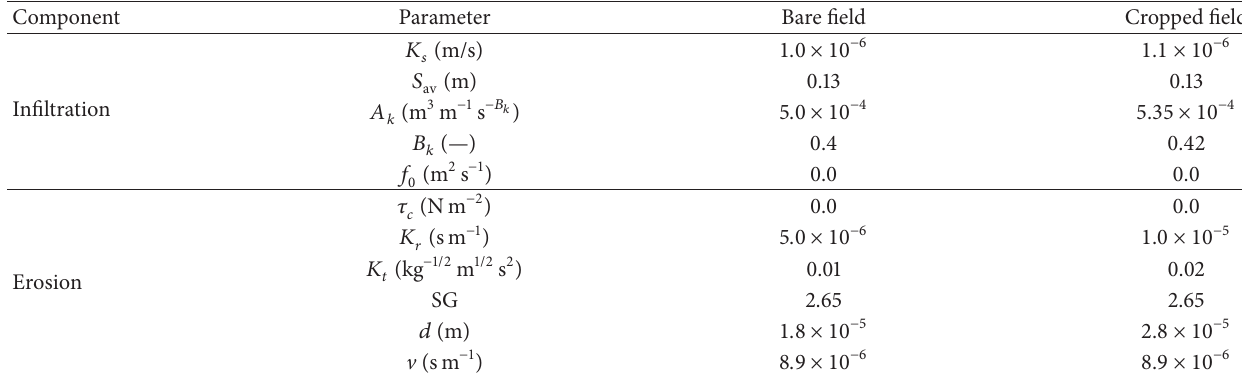
Table 1: Input data for infiltration and erosion components.